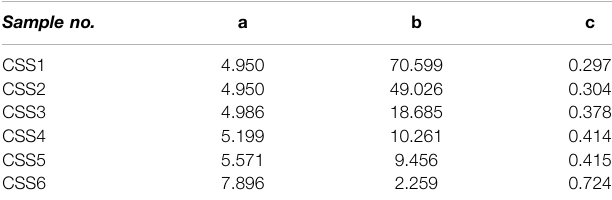
TABLE 3 | Parameters of the Fredlund-Xing model fi tting the SWCCs of calcareous silty sands with different fi nes contents. Sample